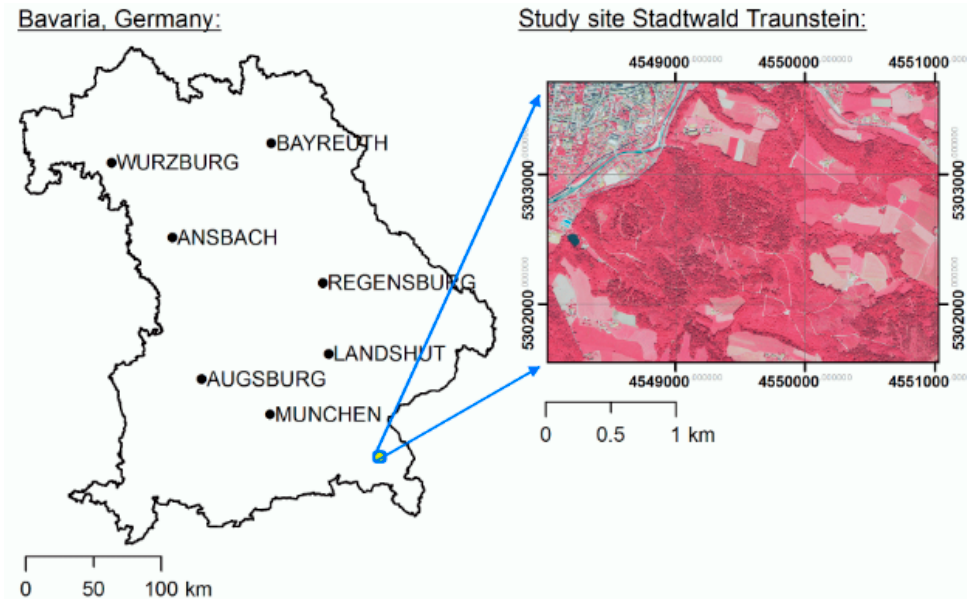
Figure 1. Geographical location of study site Stadtwald Traunstein. The left part of the figure shows the location of the study site in Bavaria, Germany. The right part of the figure shows a color-infrared orthophoto of the study site (coordinates in Gauss–Krüger system) .